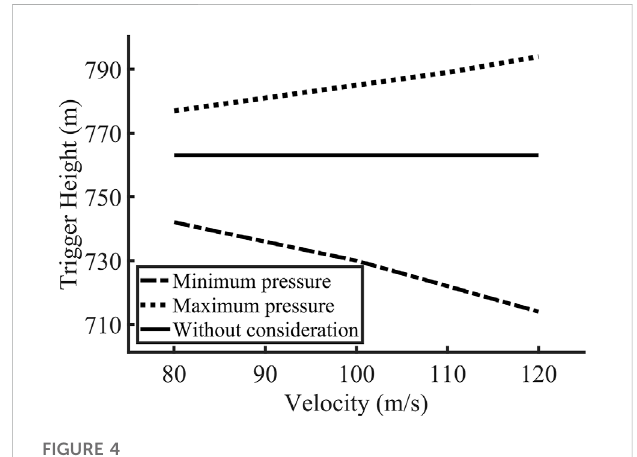
FIGURE 4 The trigger height at different velocities for minimum and maximum air pressure area.